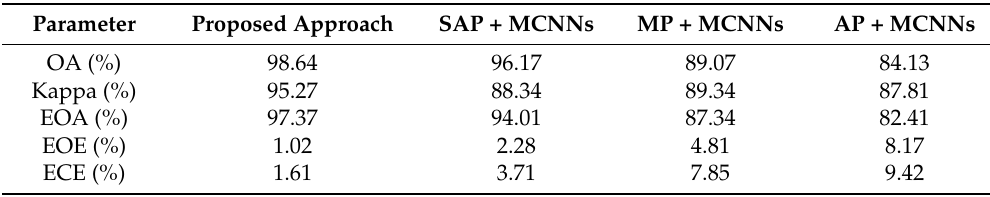
Table 3. Statistics of different CNN architectures.